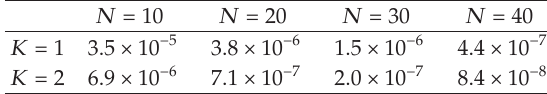
Table 1: Maximum absolute errors for Example 3.1, Case 2.